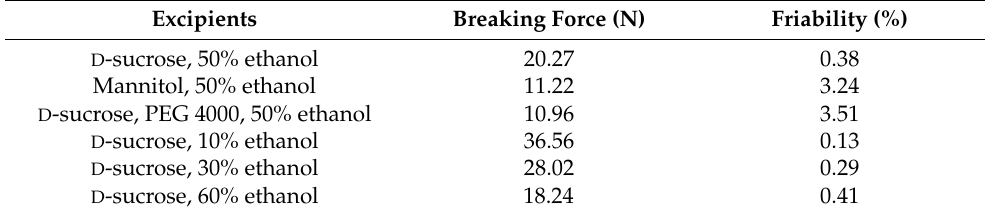
Table 4. The effect of various excipients on the mechanical properties of tablets printed with the binder jet technique